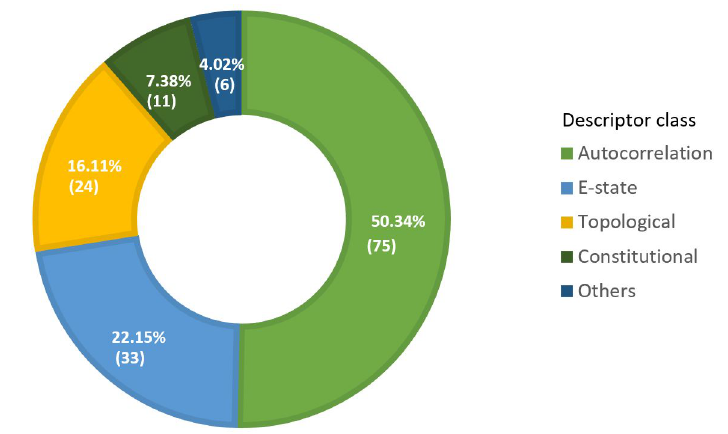
Figure 5. Donut chart to display descriptor class’s proportion (percentage contribution) in selected final descriptors subset (optimal set of